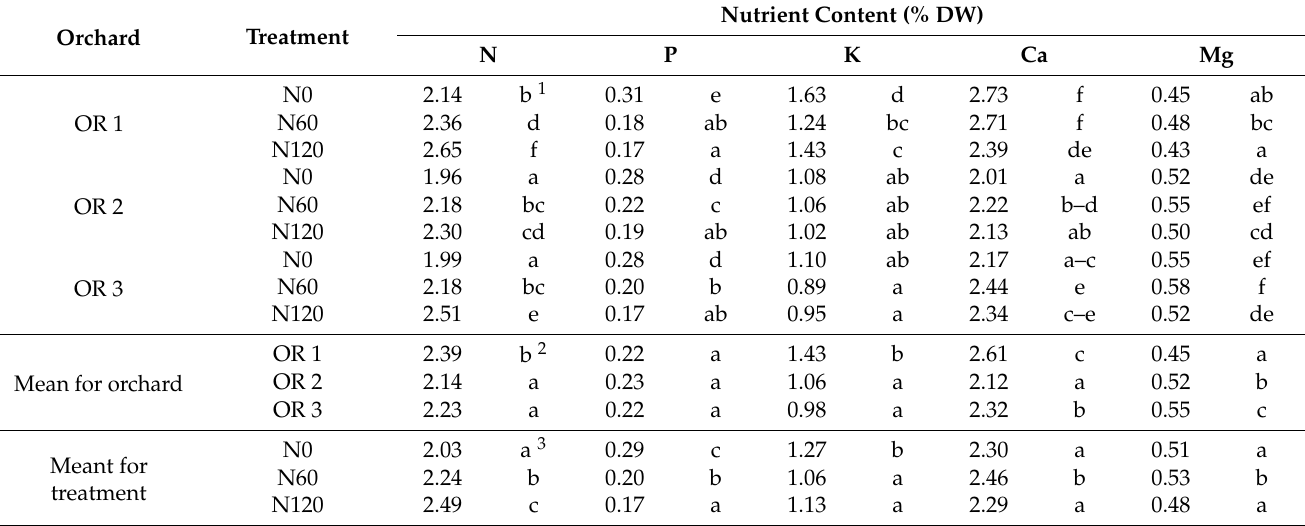
Table 6. Effect of nitrogen fertilization on component content in leaves, depending on tree age (mean values from 2010–2013).